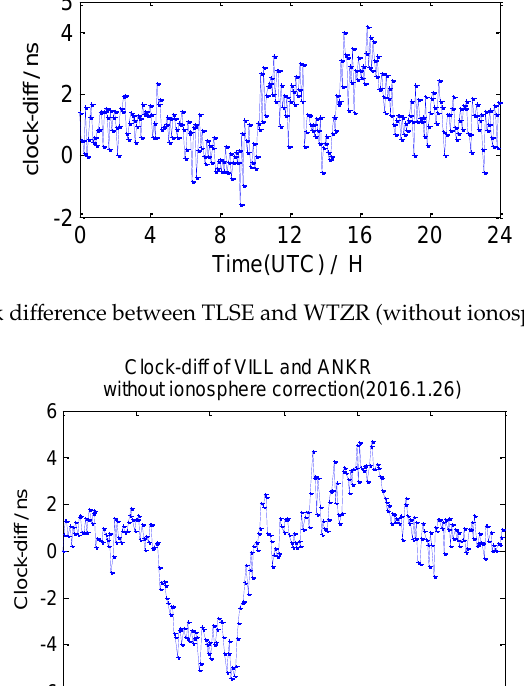
Table 4. The clock difference RMS of 7 days under three ionosphere models.